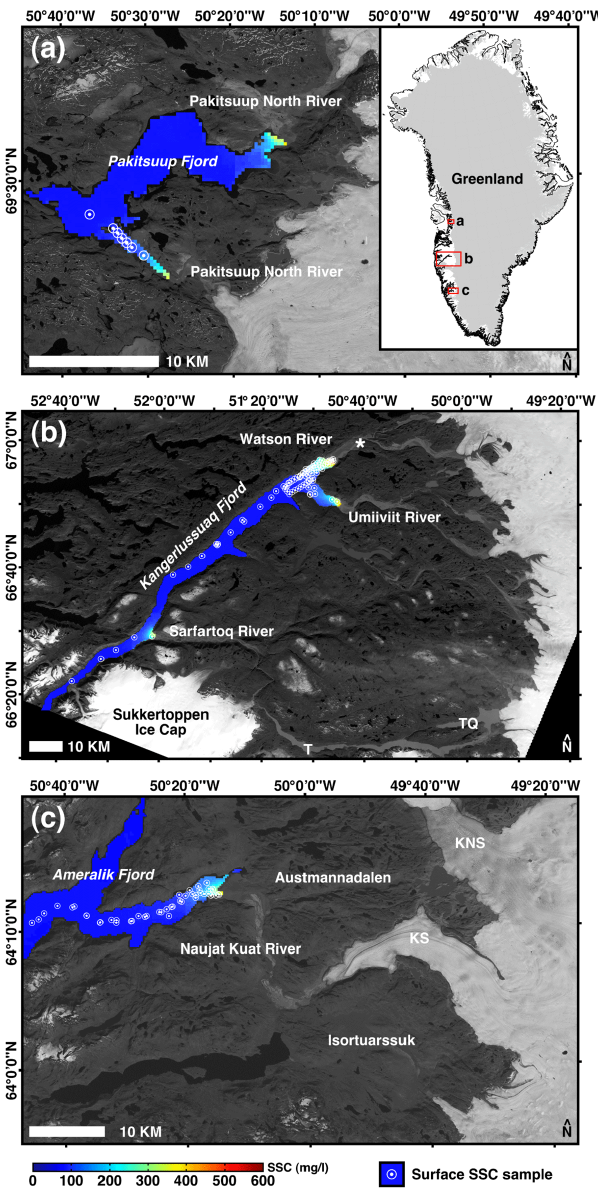
Figure 2. Overview map of study fjords, with surface sus- pended sediment concentration (SSC) sample locations used in retrieval overlaid on 13 year mean SSC values derived from MODIS algorithm. Background images are Landsat 7 ETM + from (a) 7 July 2001, (b) 20 August 2002, and (c) 3 August 2001. Inset shows location of fjords relative to Greenland Ice Sheet. An asterisk shows the location of the Watson River gauge.